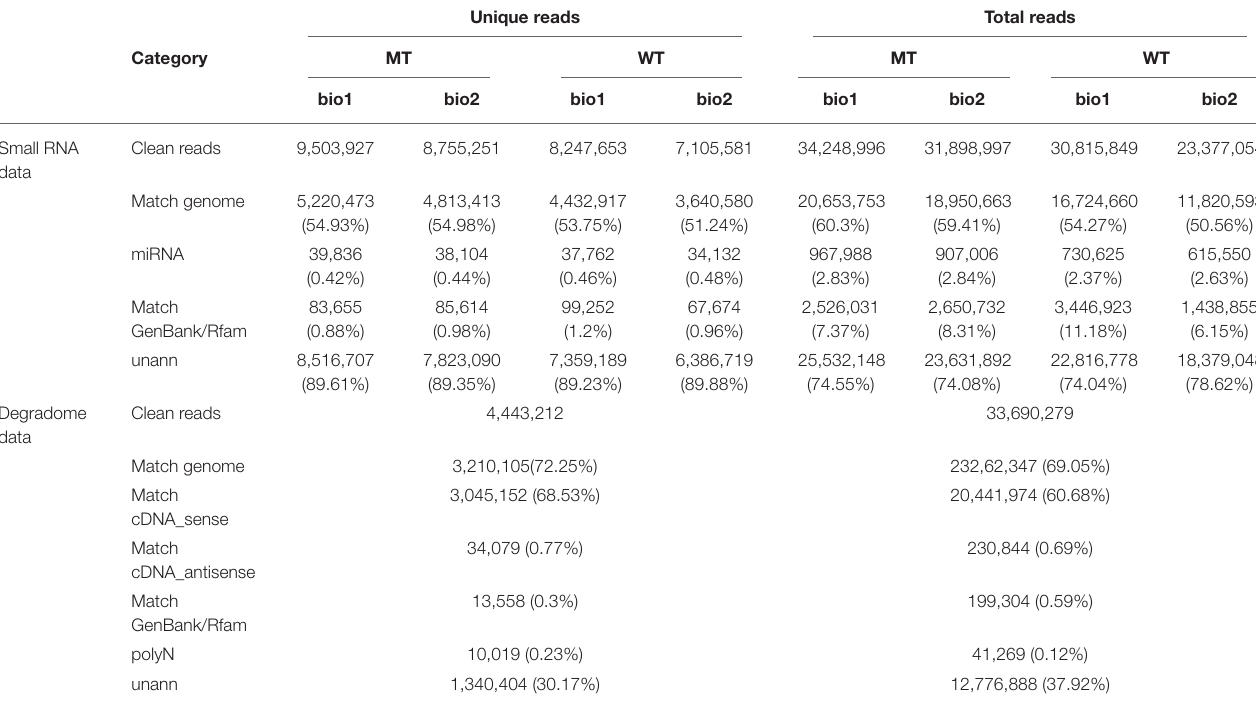
TABLE 1 | Data set summary of the sequencing of four (MT_bio1, MT_bio2, WT_bio1, and WT_bio2) small RNA and one degradome libraries. Unique